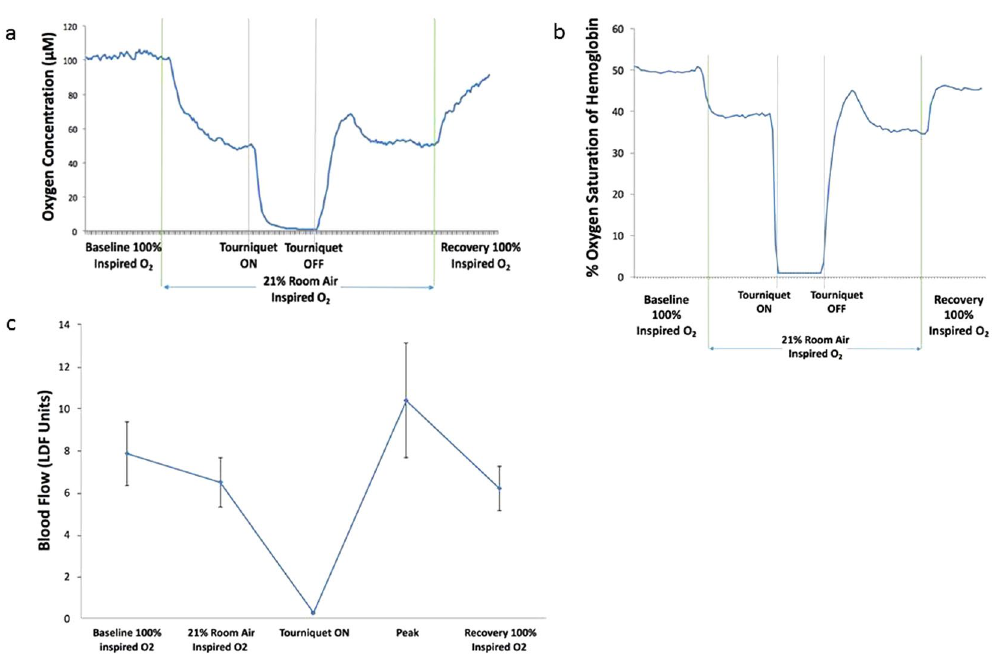
Figure 3. Right hind- limb representative graphs of ( a ) biosensor measurement. (A temporary peak occurs shortly after the tourniquet release), ( b ) NIR spectroscopy (again showing a transient peak after tourniquet release, as seen in the case of biosensor), ( c ) Laser Doppler blood flow (showing mean of three measurements at each